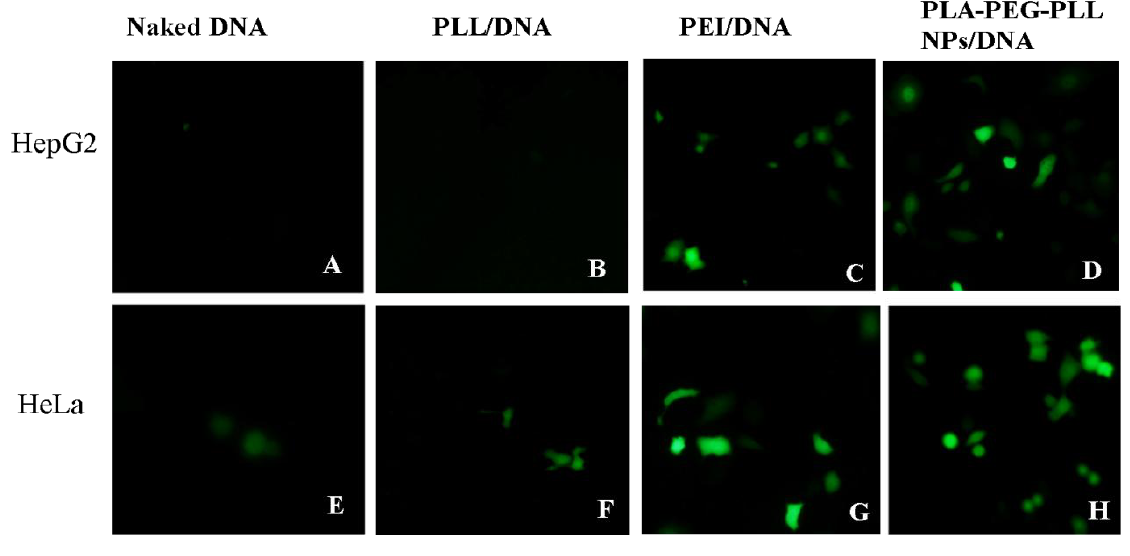
Figure 9. Fluorescent images of gene transfection of pEGFP-N HeLa cells (bottom) with naked DNA ( A , E ), PEI/DNA complexes ( B , F ), PEI/DNA complexes ( C , G ), PLA-PEG-PLL NPs/DNA complexes ( D , H )